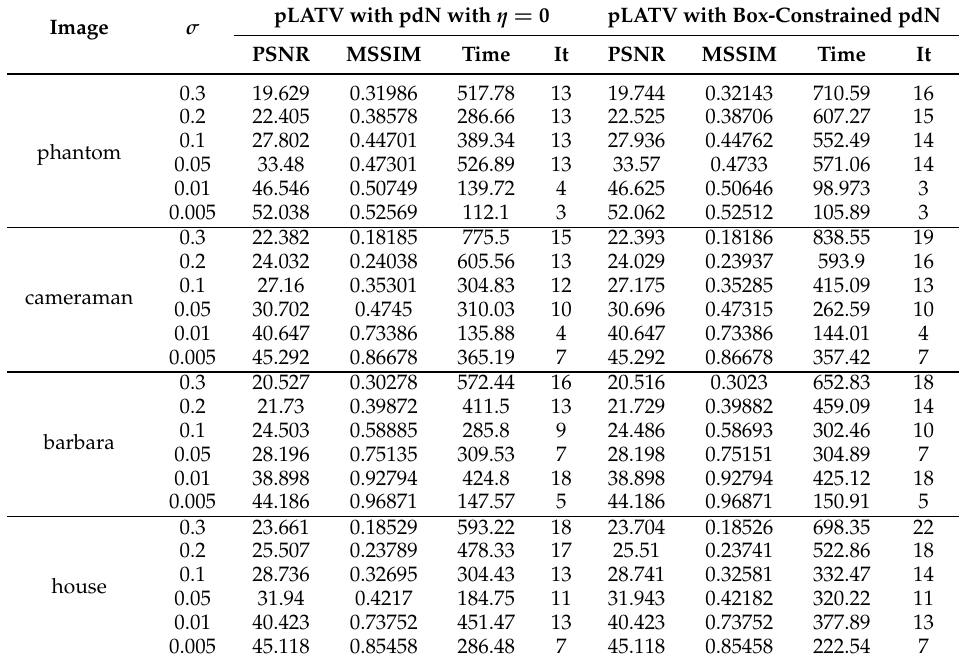
Table 9. PSNR- and MSSIM-values of the reconstruction of different images corrupted by Gaussian white noise via pLATV using the primal-dual Newton